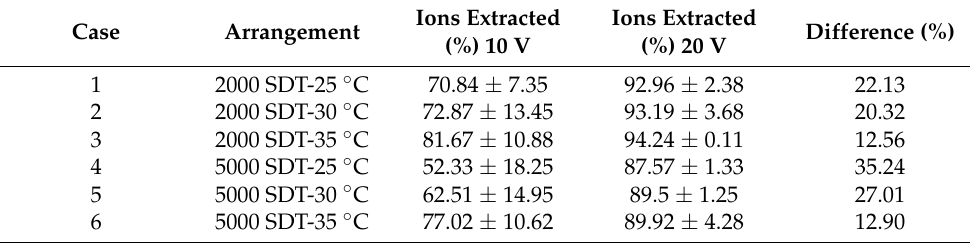
Table 5. Difference in the efficiency of experiments at 10 and 20